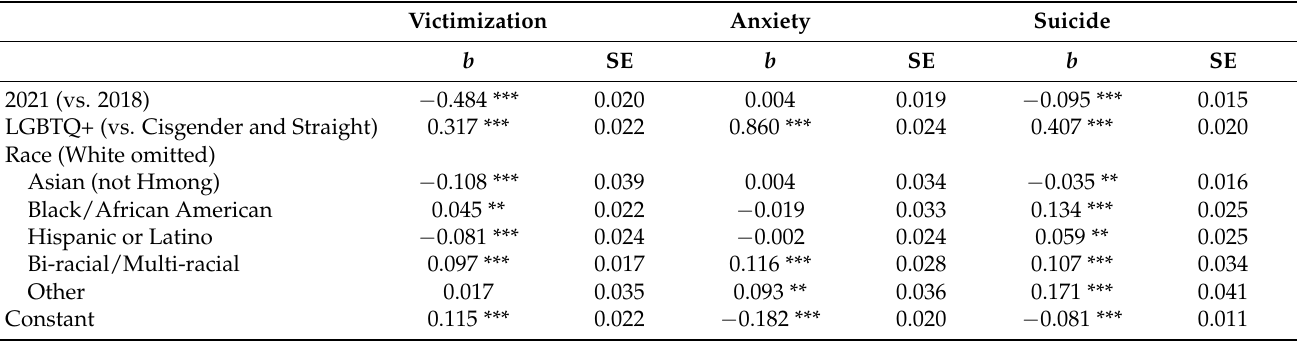
Table 3. Multivariate OLS regression examining rates of peer victimization, anxiety, and suicide attempts before and during the COVID-19 pandemic.